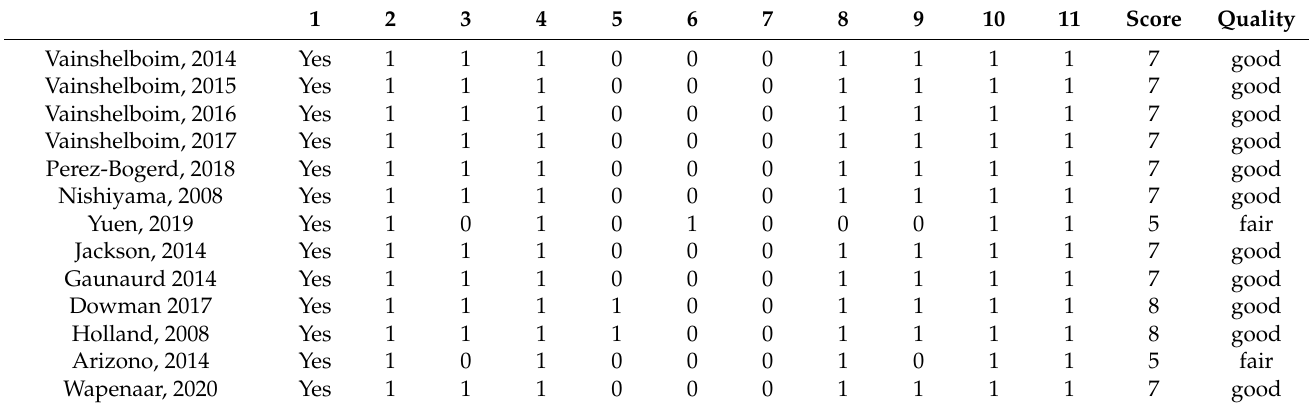
Table 1. PEDro (Physiotherapy Evidence Database) scale quality